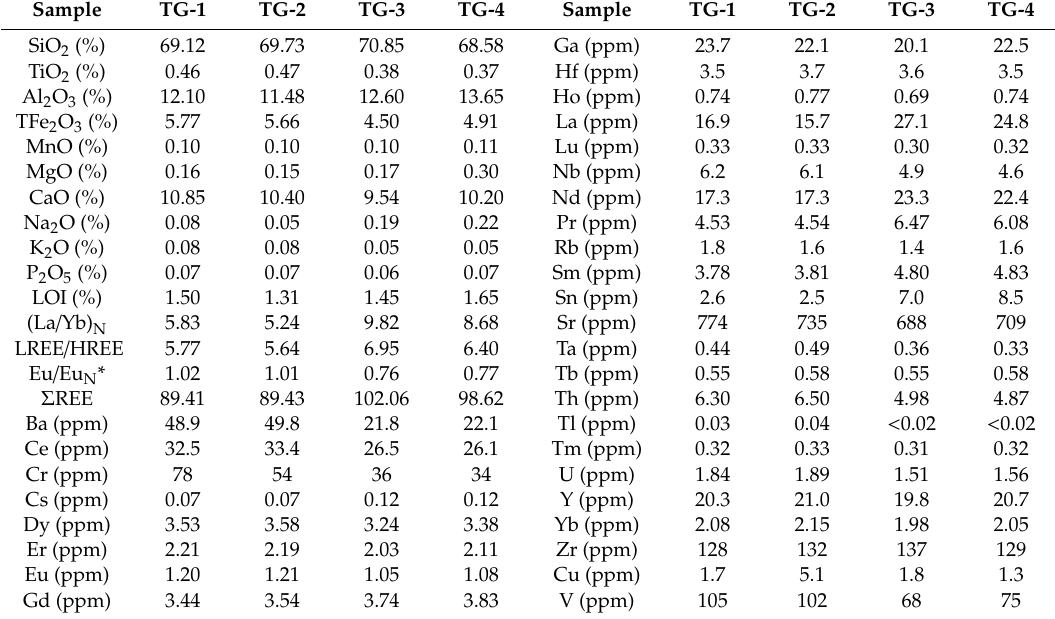
Table 2. Major (%) and trace element (ppm) data for the Tonggou